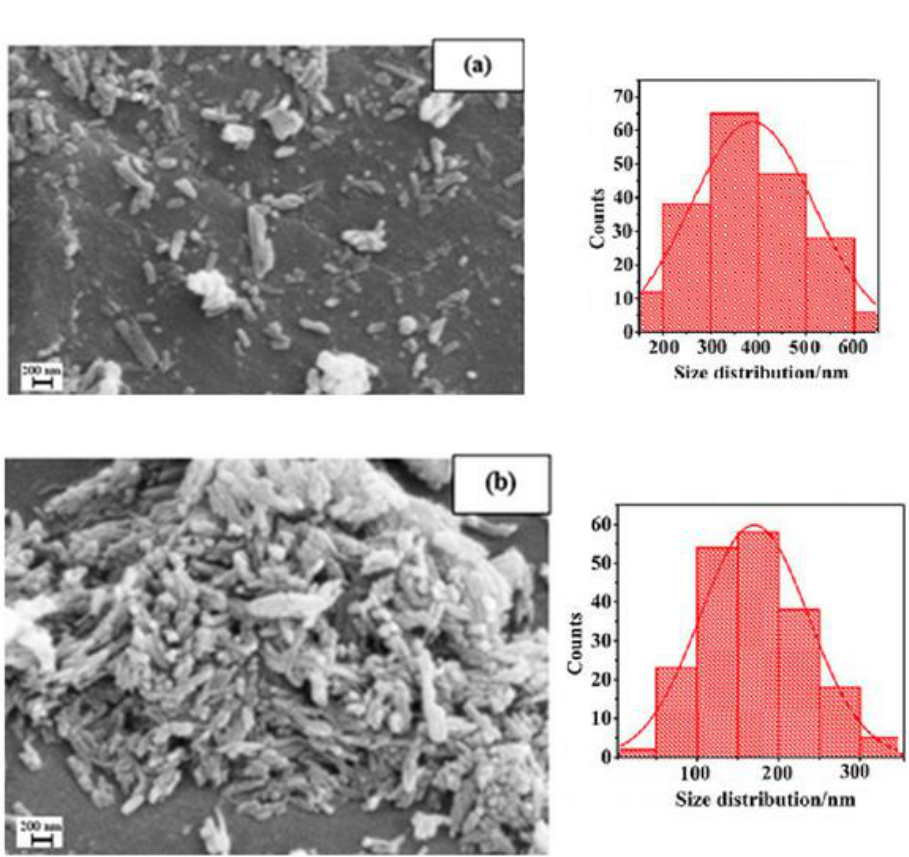
Fig. 3. SEM micrographs and histograms of: (a) Cu-TiO Figure 3. SEM micrographs and histograms of: (a) Cu-TiO 2 and (b) Pc-Cu-TiO 2 H-NC